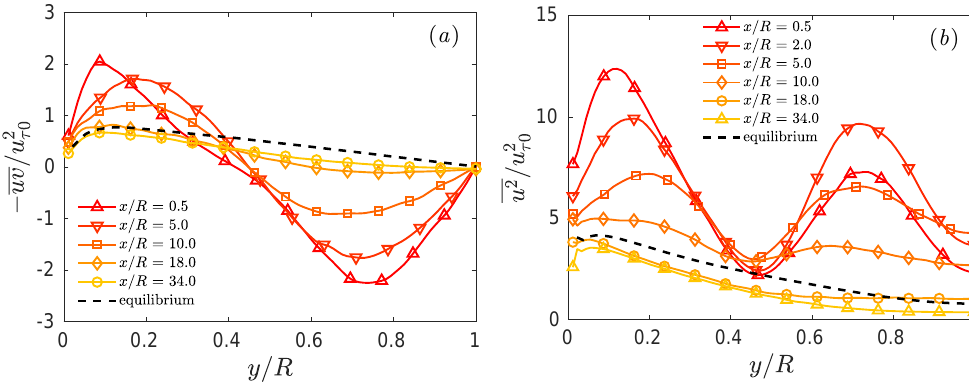
Figure 12. Development of ( a ) the Reynolds shear stress and ( b ) the axial turbulence intensity in the wake of the streamlined body of revolution (body blockage ratio =